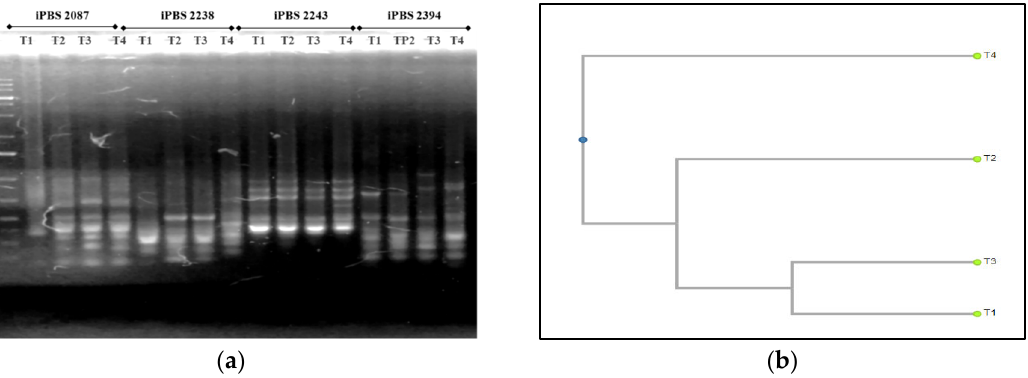
Figure 7. Results of the PCR analysis of Tilia tomentosa through the iPBS markers: ( a ) PCR pro fi les of T. tomentosa genotypes with four iPBS primers (2087, 2238, 2243, and 2394); ( b ) dendrogram of the cluster analysis (UPGMA) on the basis of ampli fi ed polymorphic bands of experimental saplings in the PCR analysis, CP = 0.950. Legend : M—molecular marker; T1, T2, T3, T4— T. tomentosa genotypes from four experimental plots.